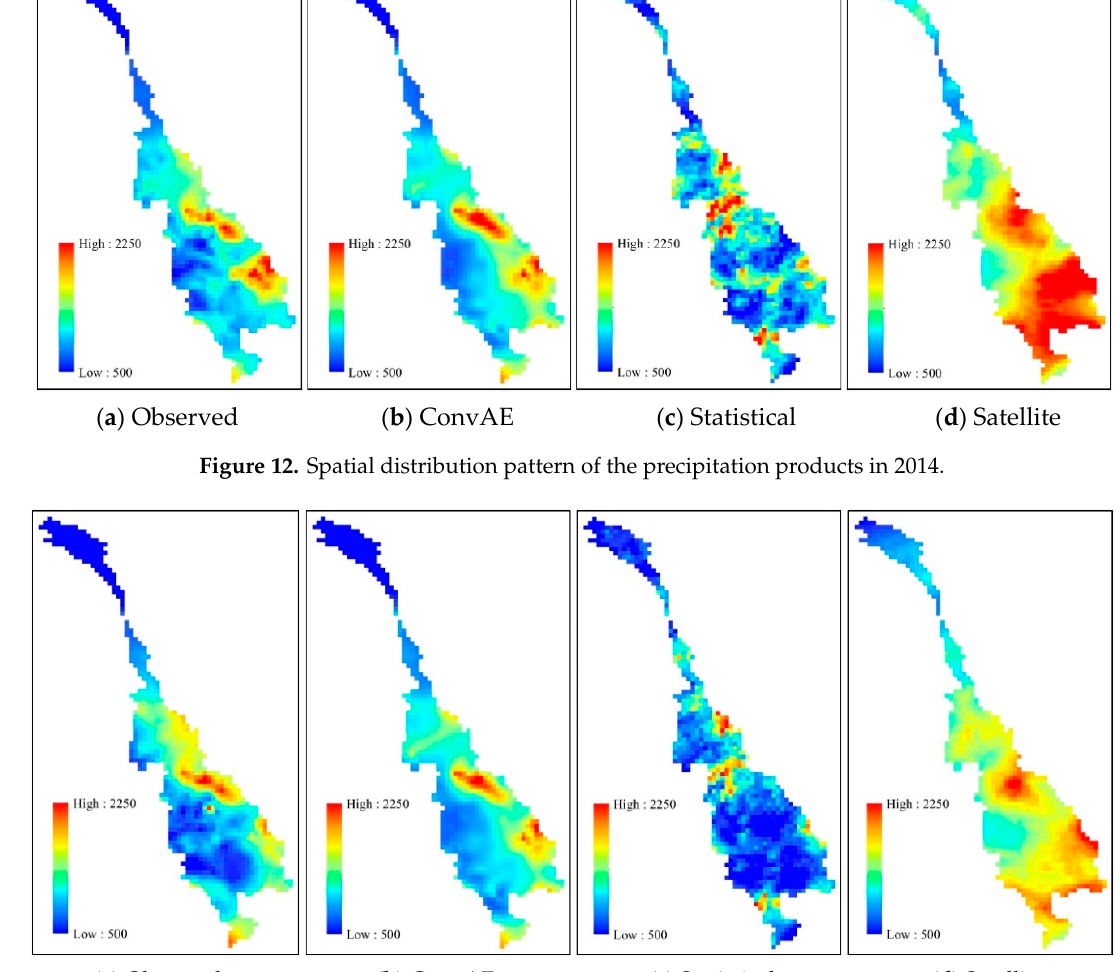
( d ) Satellite Figure 14. Spatial distribution pattern of the precipitation products in August 2014.